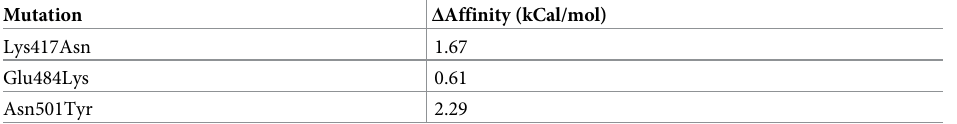
Table 3. Δ Affinity calculations for RBD variants of spike protein in SARS-CoV-2 501Y.V1 and SARS-CoV-2 501Y.V2.